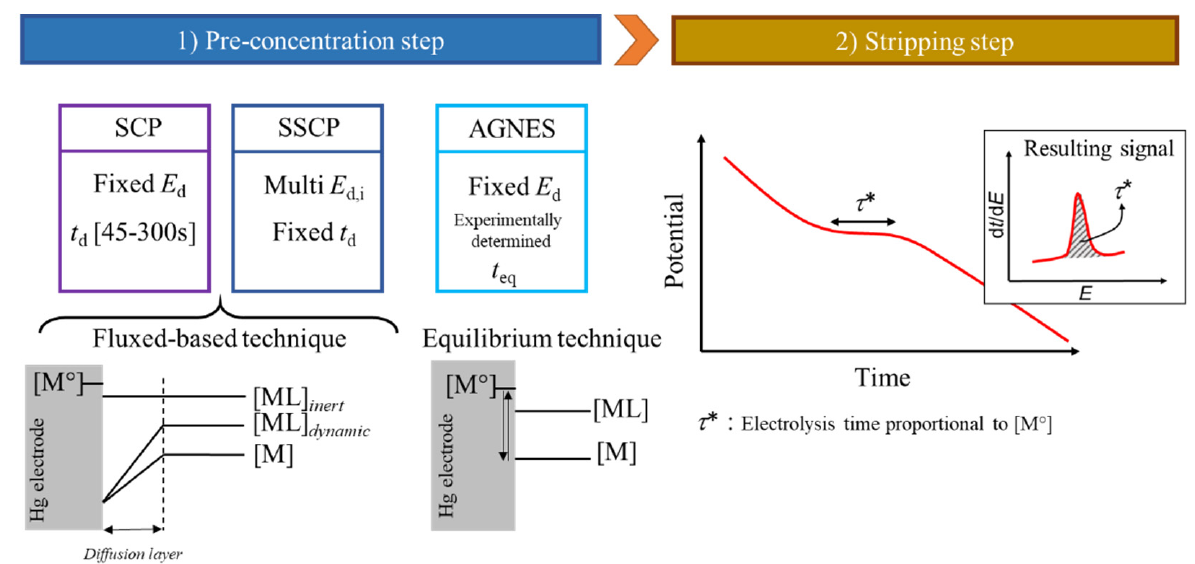
Figure 1. Generic description of SCP, SSCP and AGNES.